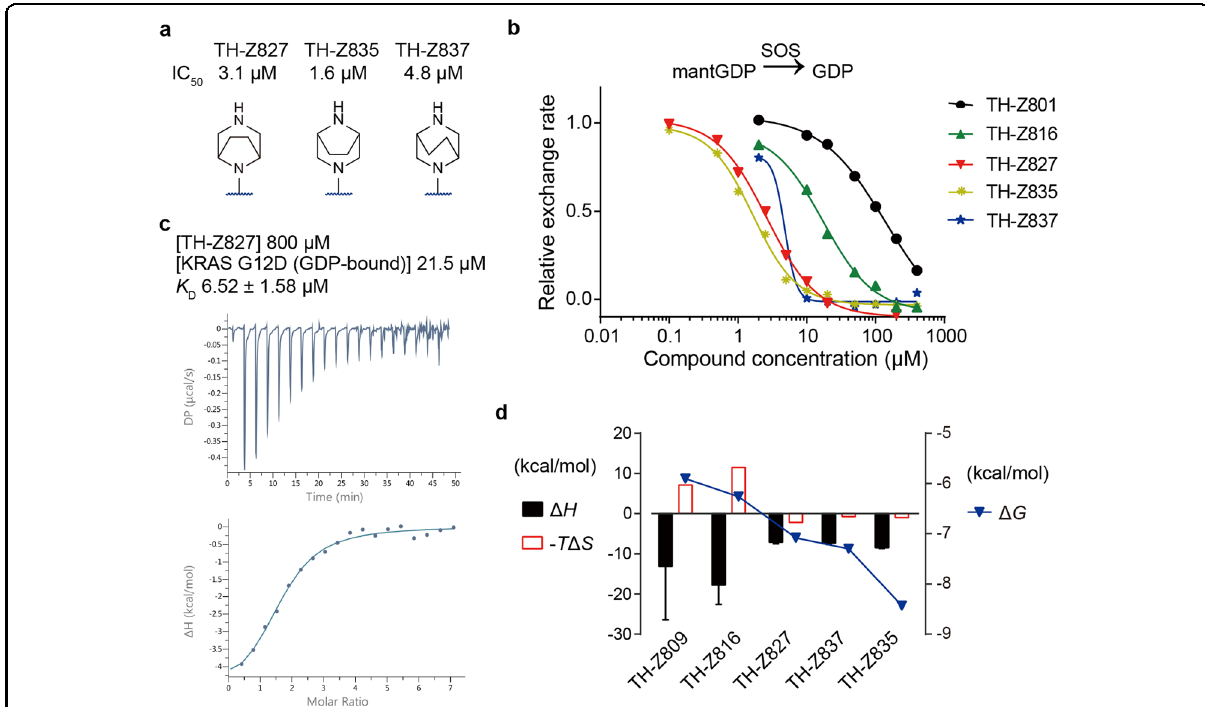
Fig. 2 A cyclization strategy to improve inhibitory activities and binding potency. a Chemical structures of bicyclic compounds TH-Z827, TH- Z835, and TH-Z837. b Inhibitory activities of these bicyclic compounds on KRAS(G12D) measured by SOS-catalyzed nucleotide exchange assay with GDP as the incoming nucleotide. c ITC assay of the TH-Z827 (800 μ M) and GDP-bound KRAS(G12D) (21.5 μ M). d Δ G , Δ H, and Δ S analysis of compounds tested by ITC assays. For each compound, Δ H and - T Δ S values are presented referring to the left axis, while the Δ G value is presented referring to the right